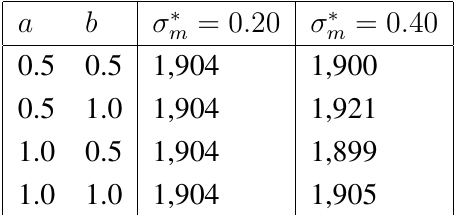
Table 3. Value of V